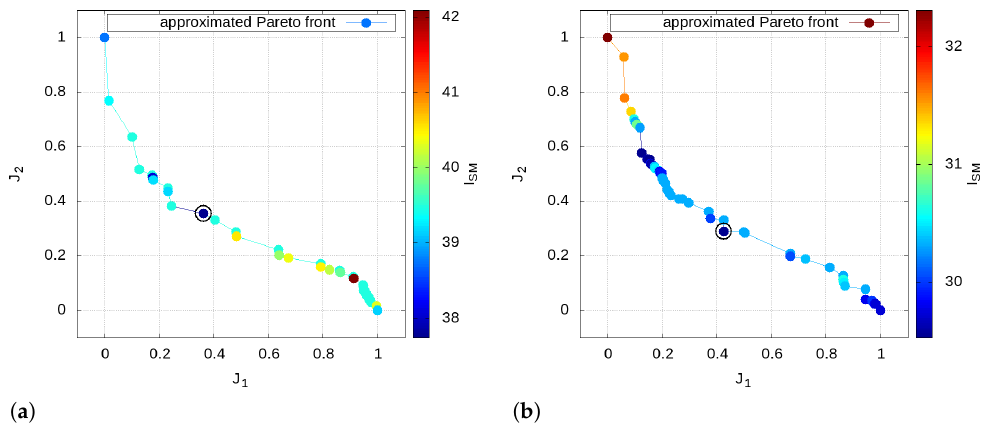
Figure 18. Solutions of the multiobjective problems for the takeoff operations: mapped approximated Pareto optimal solutions with the sound-matching index I SM as parameter. The marked solutions are the ones with the minimum I SM . ( a ) single–aisle, ( b )